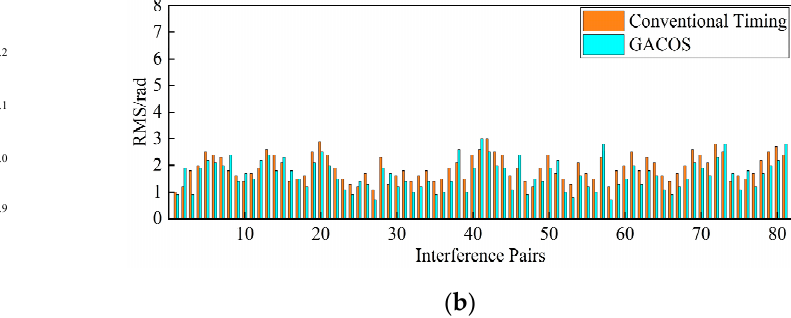
Figure 4. ( a ) GACOS data corresponding to the main image; ( b ) Standard deviation of atmospheric delay phase.